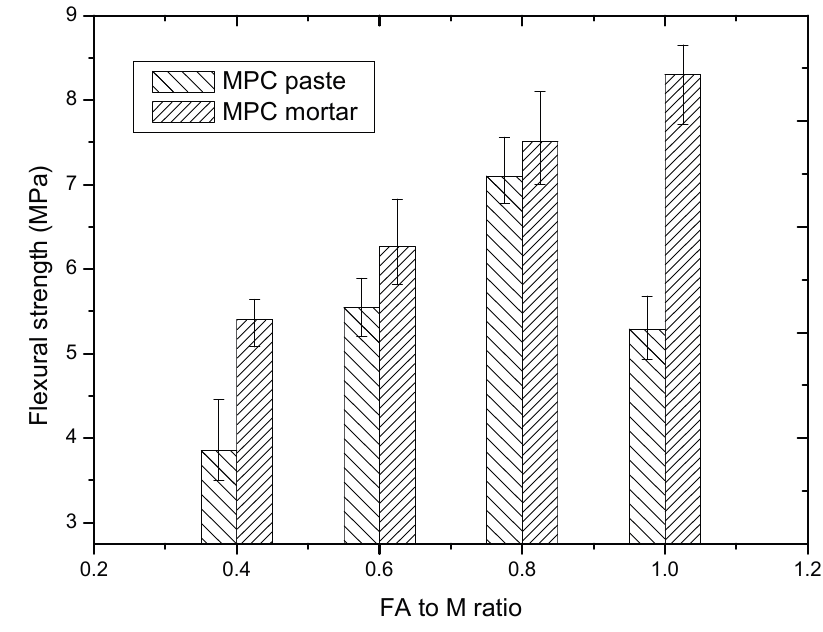
Figure 8. Flexural strength (at 7th day) of MPC pastes and MPC